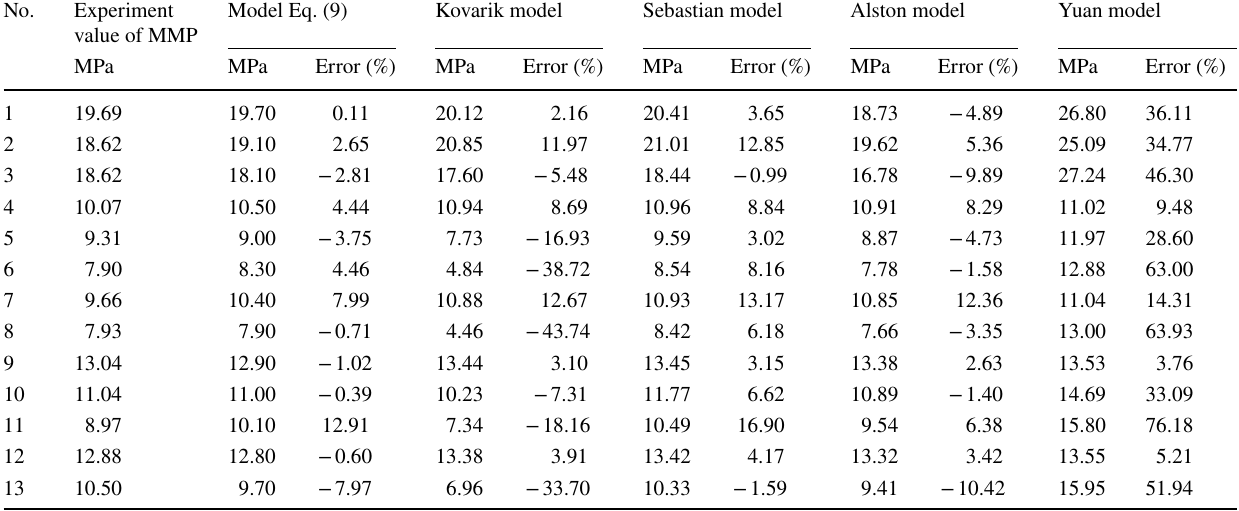
Table 1 Results of MMP prediction model No. Experiment Model Eq. value of MMP